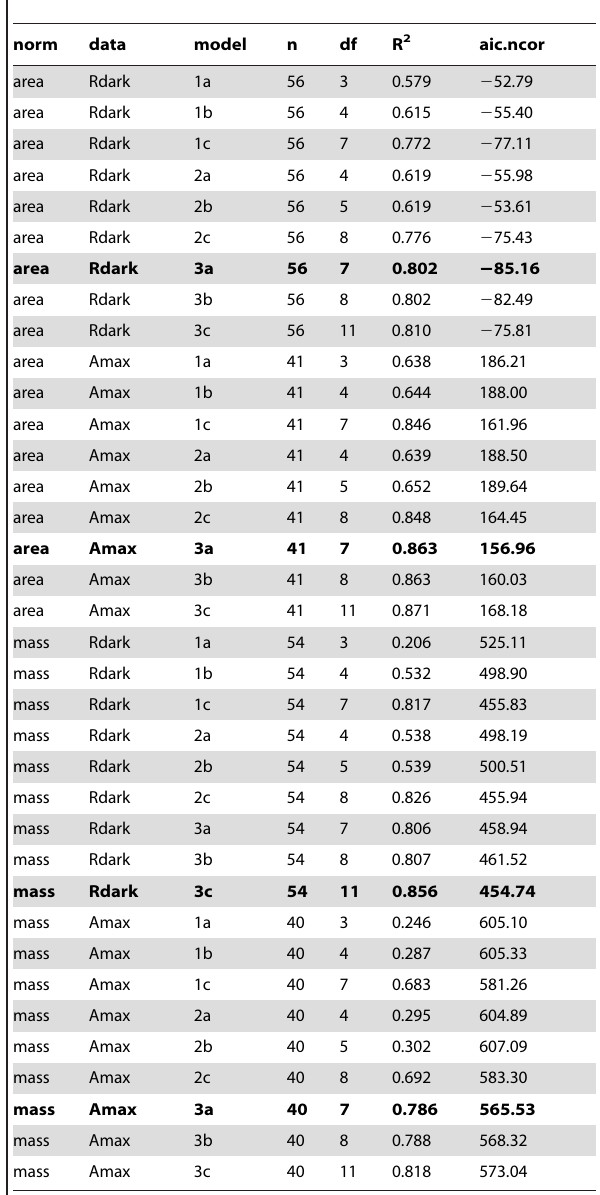
Table 1. Comparison of models of leaf maximum net photosynthetic capacity (Amax) and dark respiration rate (Rdark) in response to light